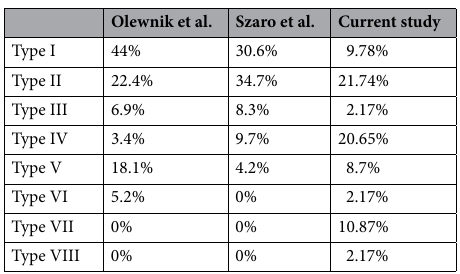
Table 3. Comparison of the insertion of the PM (Olewnik et al. 11 ; Szaro et al. 33